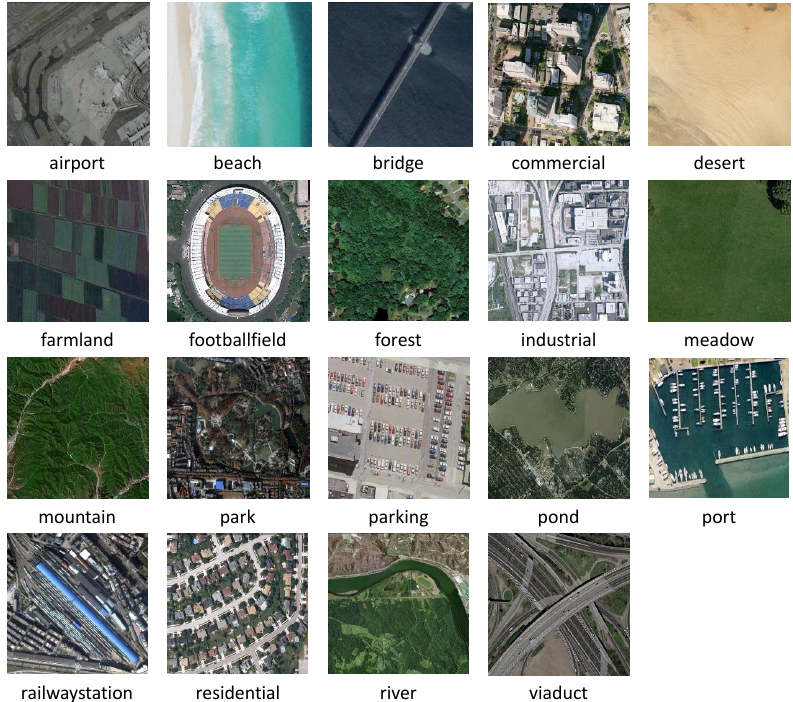
Figure 9. RS19dataset: this contains 19 classes of scenes in optical high-spatial resolution satellite imagery that are exported from Google Earth with various resolutions. For each class, there are 50 samples, and the image sizes are 600 × 600